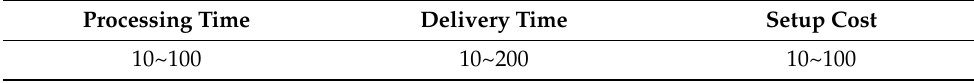
Table 2. Parameter of input data in large-scale problems.